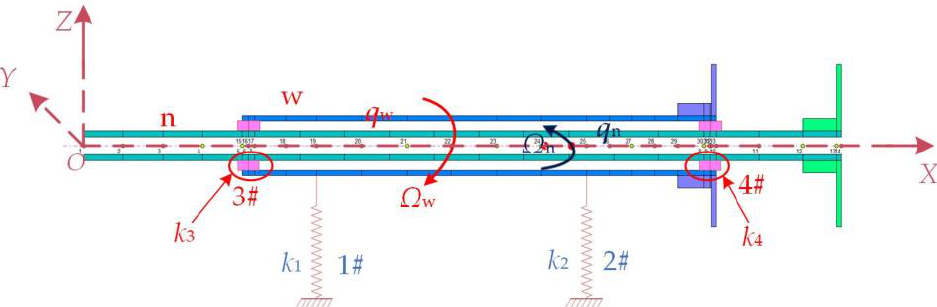
Figure 3. Equivalent dynamics model of coaxial counter-rotating dual-rotor system.